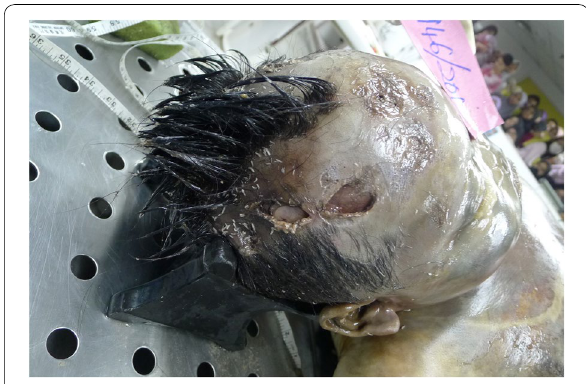
Fig. 3 Various sizes of fly larvae were seen infesting the body of case